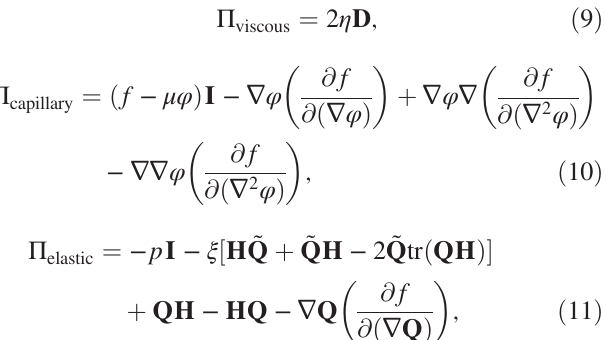
are indicated by β ¼ π = 2 .